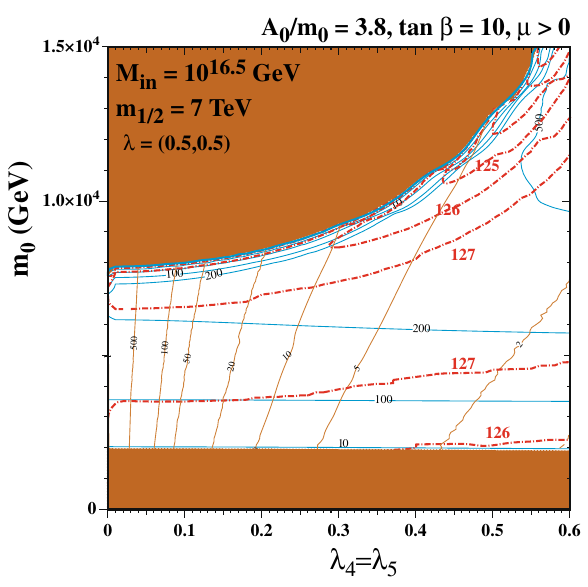
Fig. 7 Representative ( m 1 / 2 , m 0 ) planes in the FSU(5) GUT model. Parameters as in Fig. 1, except that A 0 / m 0 = 3 . 8, λ 4 = λ 5 = 0 . 5 (left), and M in = M P with λ 4 = λ 5 = 0 . 3, (right). Regions with a stau LSP, stop LSP or tachyonic stop/stau are shaded brown. The contours are as in Fig. 1